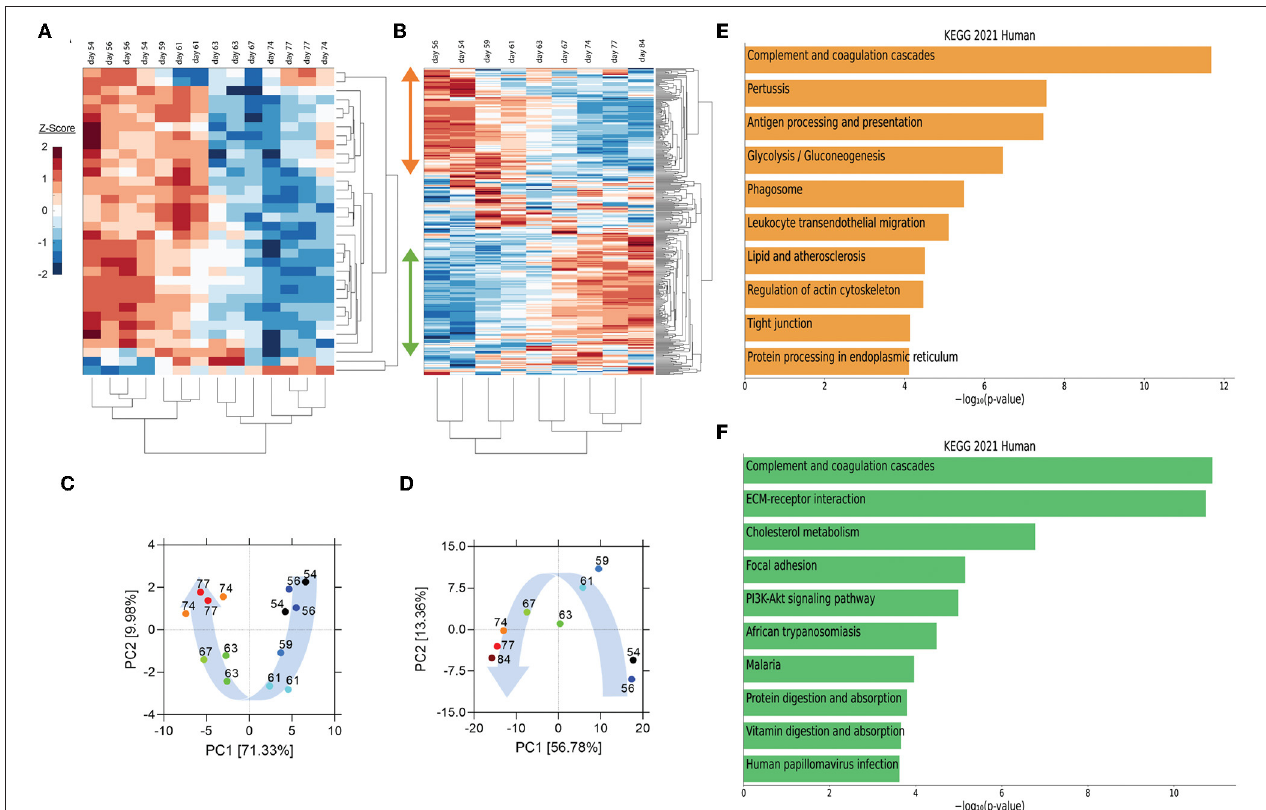
FIGURE 2 | Unsupervised hierarchical clustering and principal component analysis (PCA) of cytokines and proteins in the recipient’s plasma before and after convalescent plasma transfusion. (A,B) Unsupervised hierarchical clustering was performed on plasma cytokine profile and proteomic data using MATLAB. Vertical arrows in (B) mark the set of proteins that decrease (orange arrow) or increase (green arrow) following transfusion. (C,D) PCA was conducted on plasma cytokine profile (C) and proteome (D) . The variance accounted for by PC1 is shown on the x-axis and the variance accounted for by PC2 on the y-axis. Numbers indicate days post-symptom onset as shown in (A,B) . Blue arrows illustrate the distribution of PC1 scores, which were self-organized in a temporal trajectory. (E,F) The top 10 enriched KEGG pathways for proteins that decrease (orange bars) (referred to as module A in Supplementary Figure S2 and in the text) or increase (green bars) (module B in Supplementary Figure S2 and in the text) using EnrichR Pathway